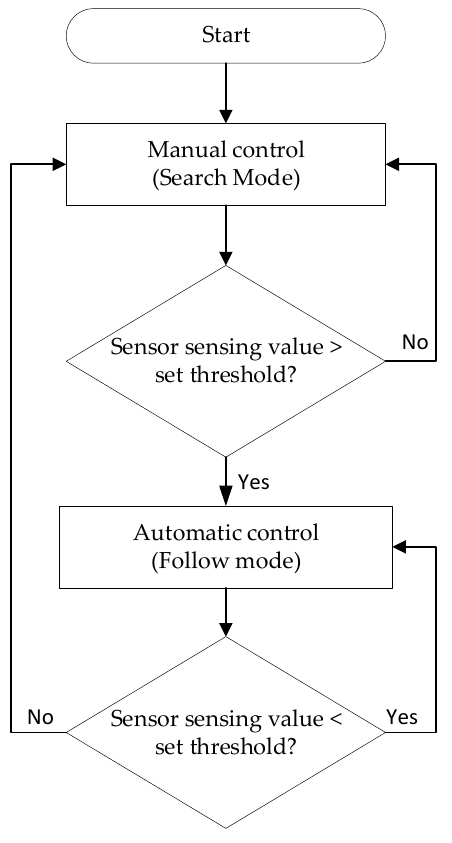
Figure 7. UAV control flow chart.